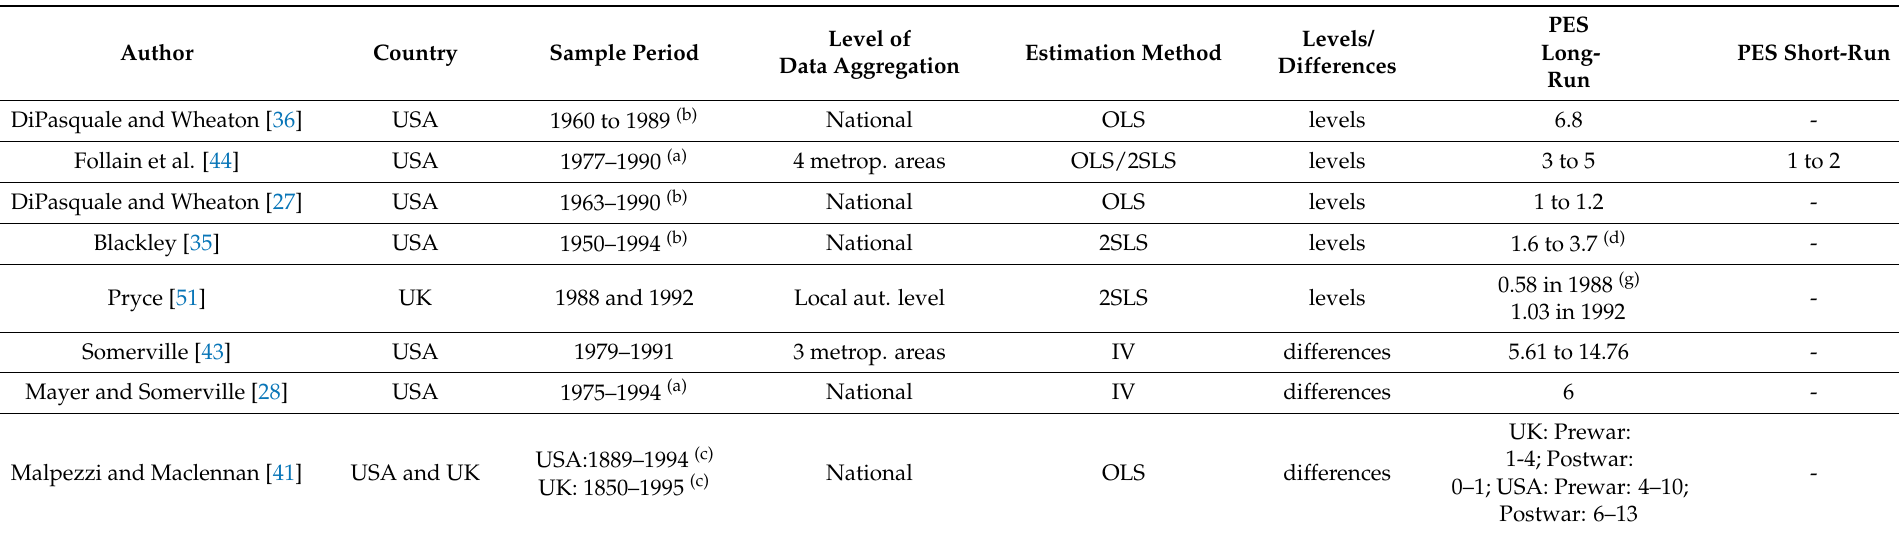
Table 2. The second generation of literature in housing supply (contemporary